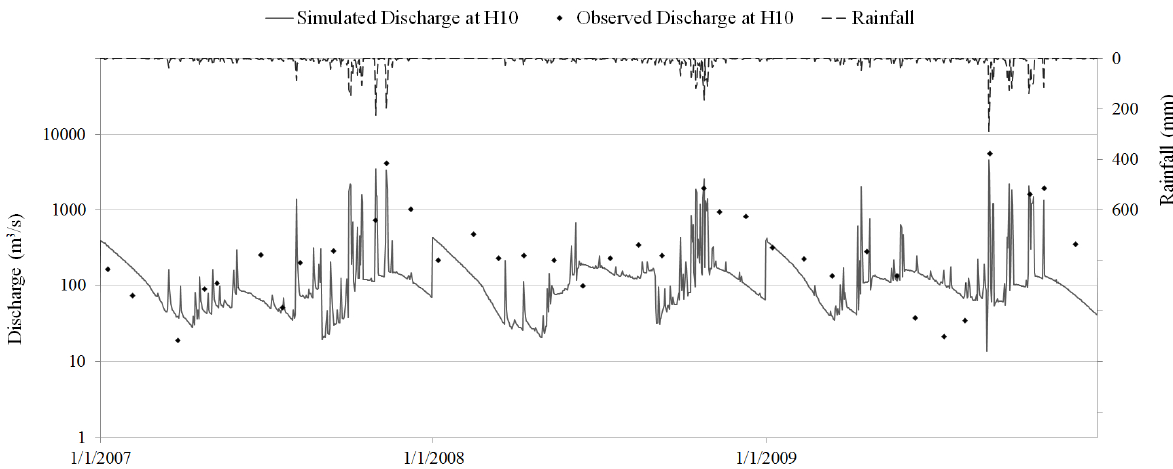
Figure 8. River discharge validation at